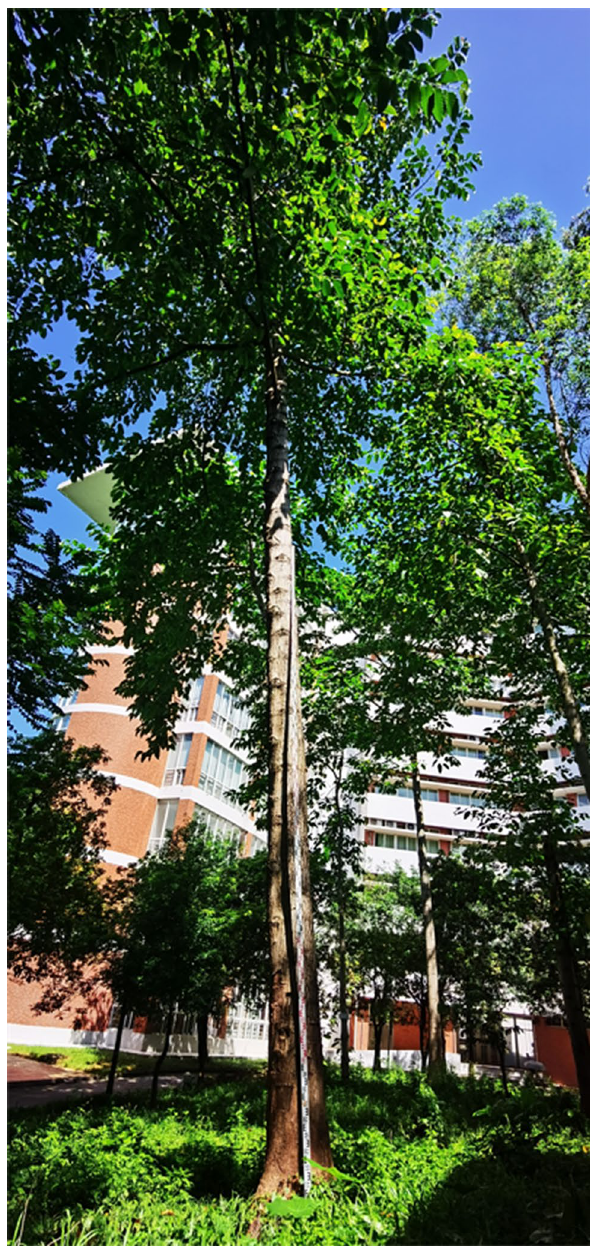
Figure 4. The tree of Neolamarckia cadamba from which young leaves were sampled for mtDNA sequencing. The tree grows on campus of South China Agricultural University (23°16 ′ N 113°35 ′ E), Guangzhou, China. It is about 14.5 m in height and 49.04 cm in diameter at the breast height in eleven